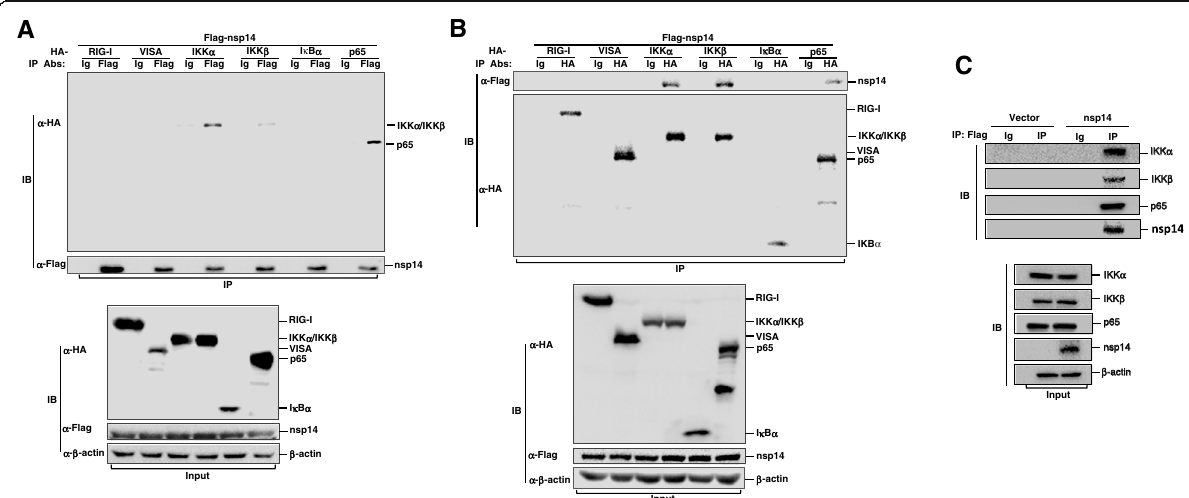
Fig. 5 PEDV nsp14 interactes with IKK α , IKK β and p65 in NF- κ B pathway. A and B HEK-293T cells were cotransfected with Flag-nsp14 expression plasmids and the indicated HA-tagged molecule expression plasmids (RIG-I, VISA, IKK α , IKK β , I κ B α or p65). At 36 hpt, cell lysates were prepared for Co-IP experiments using anti-Flag antibody ( A ), anti-HA antibody or ( B ) nonspecific mouse IgG. Western blotting analysis was carried out with the indicated antibodies to evaluate the whole cell lysates (WCLs) and immunoprecipitation complexes. C IPEC-J2 cells were transfected with Flag- nsp14 expression plasmids for 36 h. Then, cell lysates were prepared for Co-IP experiments using anti-Flag antibody or nonspecific mouse IgG. Western blotting analysis was carried out with the indicated antibodies to evaluate WCLs and IP